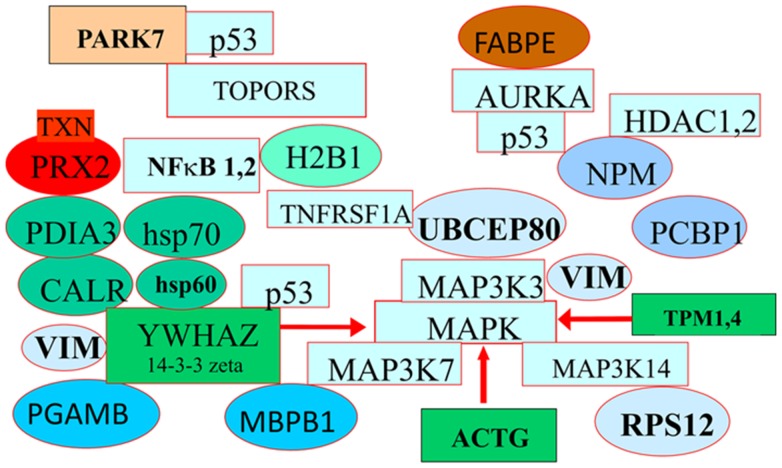
Pathway construction based on the proteins identified from 2D PAGE and ESI-MS/MS Analysis. Genes/proteins identified from proteomic data analyses were categorized into pathways based on NCBI, OMIM, KEGG and Gene Cards. Colour boxes represent the proteins identified by ESI-MS/MS- chaperones and folding catalysts (HSP70, CALR, TRX, PRX2, PDIA3); structural proteins (UBCEP80, H2B1, ACTG, TPM4, VIM, FABPE); Single stranded nucleic acid binding proteins NPM1,PCBP1); Glycolytic pathway enzymes (PGM, ENO1,TPI); PARK7,NACA. Blue boxes indicate interacting partners not identified by ES-MS/MS but are common between the identified proteins as interacting partners. Red arrows indicate that the proteins identified belonging to common categories and possessing common interacting partners converge onto MAPK signal transduction pathway.